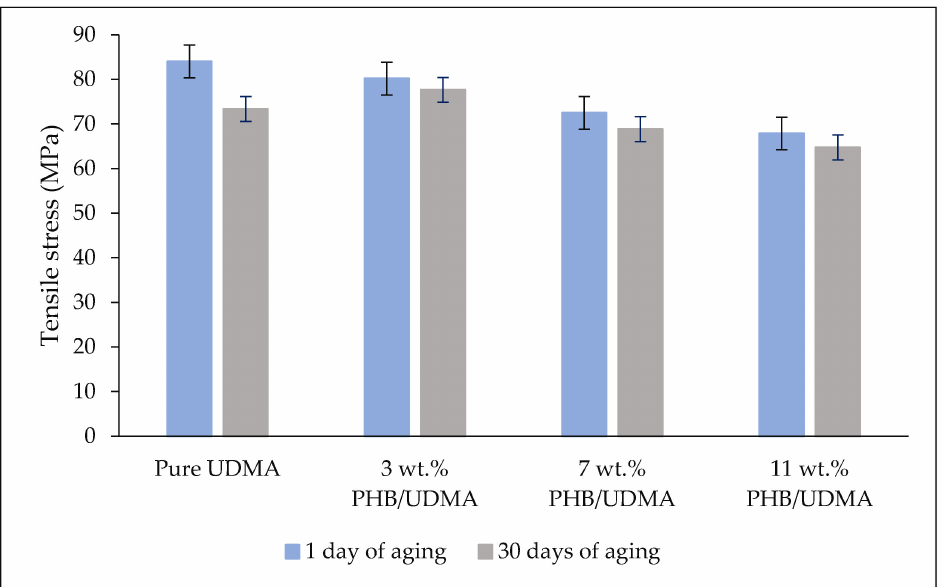
Figure 4. Comparative results of tensile stress of varied 3D printed PHB/UDMA after a day and a month of